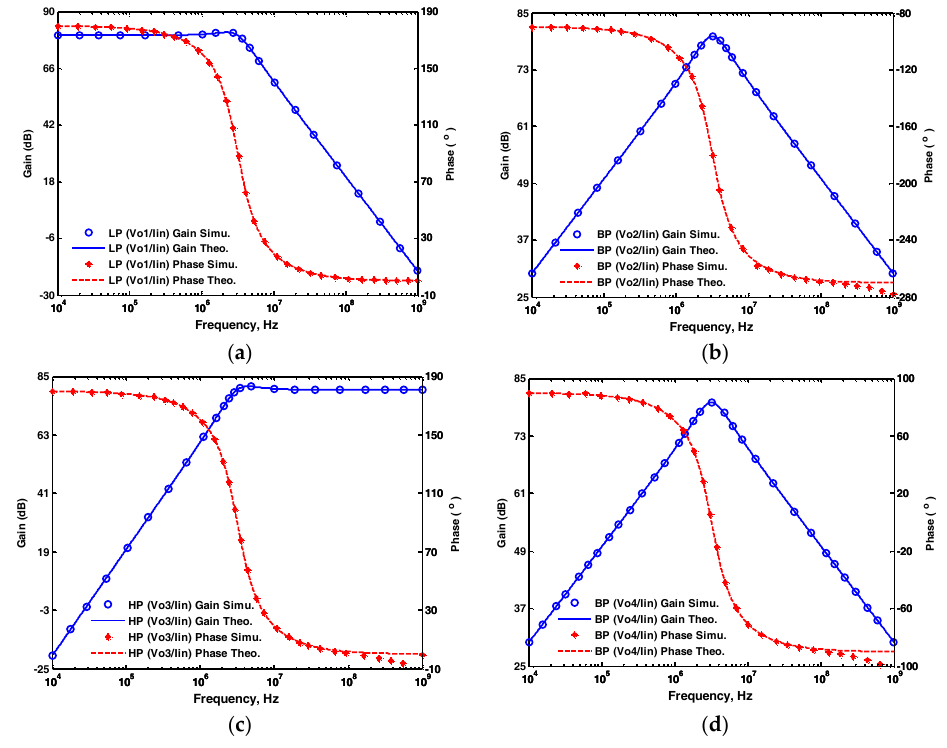
Figure 9. The TIM-simulated frequency responses of Figure 2 ( a ) lowpass filter; ( b ) bandpass filter; ( c ) highpass filter; and ( d ) bandpass filter.